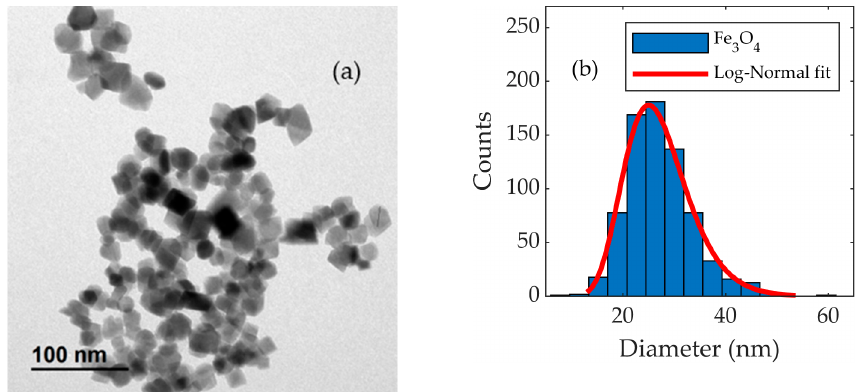
Figure 3. ( a ) Typical TEM image of the Fe 3 O 4 nanoparticles and ( b ) TEM image analysis resulting in the histogram, fitted with a normal